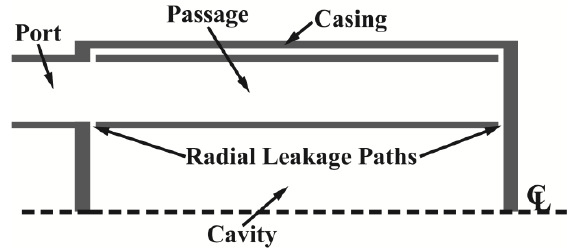
Figure 2. Illustration of wave rotor leakage in radial direction. Energies 2018 , 11 , x FOR PEER REVIEW